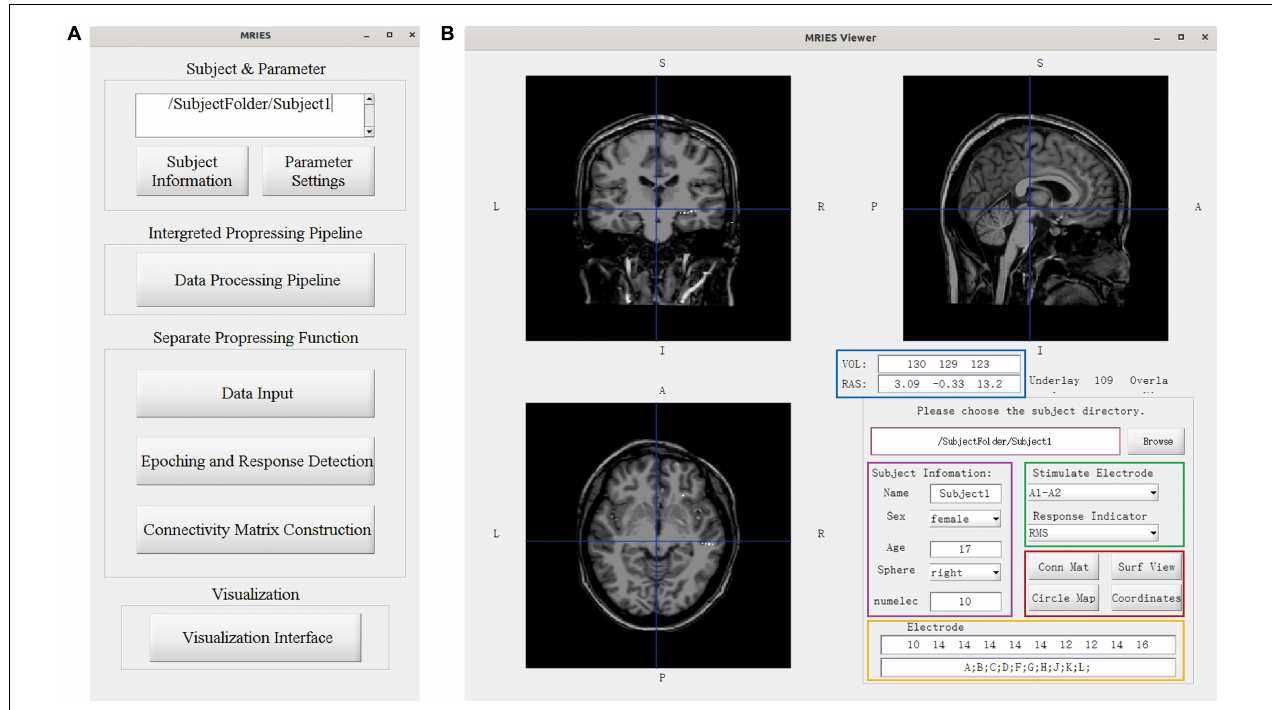
FIGURE 3 | Main GUI of the toolbox. (A) Data processing GUI, including the processing pipeline, separate processing step, and visualization. (B) Visualization GUI. The individual brain is shown in different views. The lower right part shows the information and controllers highlighted in the color-coded box. The volume and voxel coordinates are illustrated in the blue box. The subject information is illustrated in the pink box. The electrode information is illustrated in the yellow box. The specific stimulated electrode pair and indicator illustrated in the green box can be chosen and then the responses to this electrode pair are shown in the volume space. Other visualization GUIs and 3D-electrode locations are shown in the red